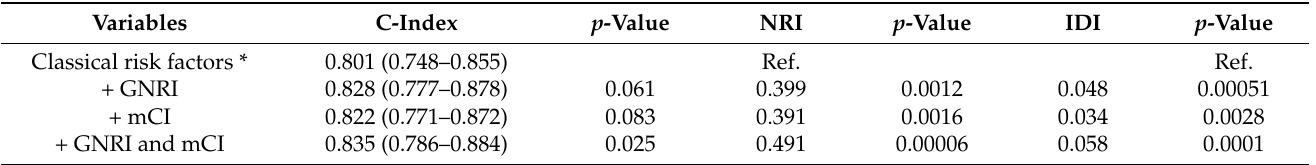
Table 3. Predictive accuracies of GNRI and mCI for all-cause